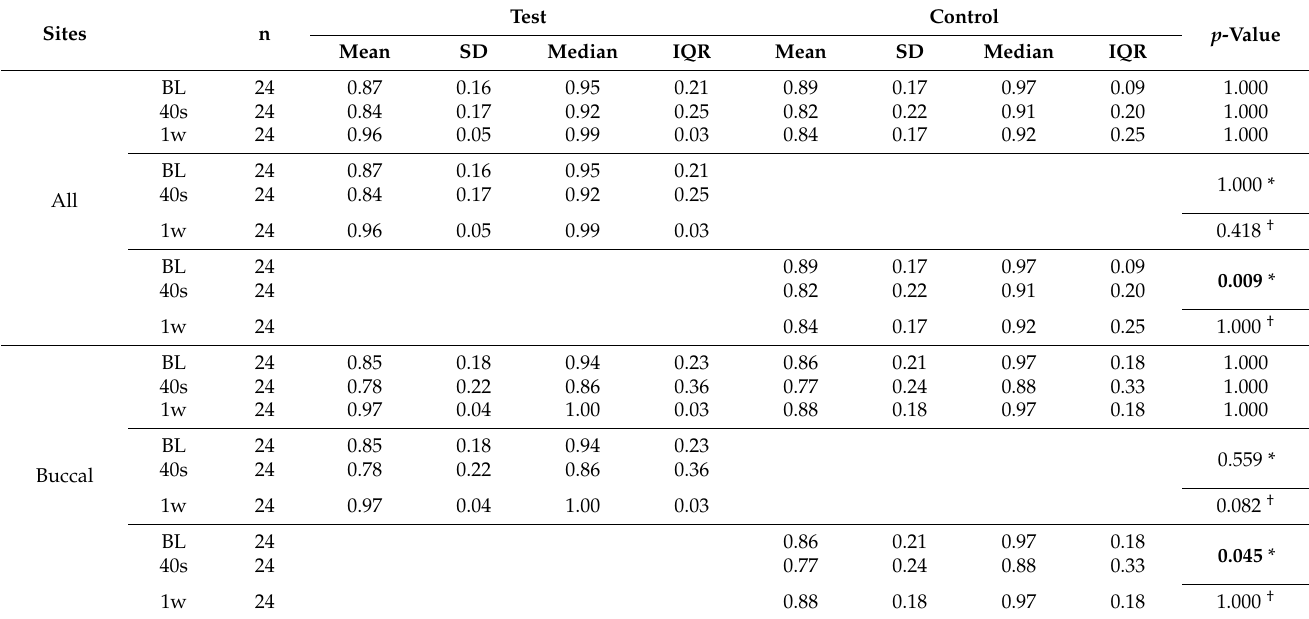
Table 3. Plaque index analysis with the repeated measures Friedman